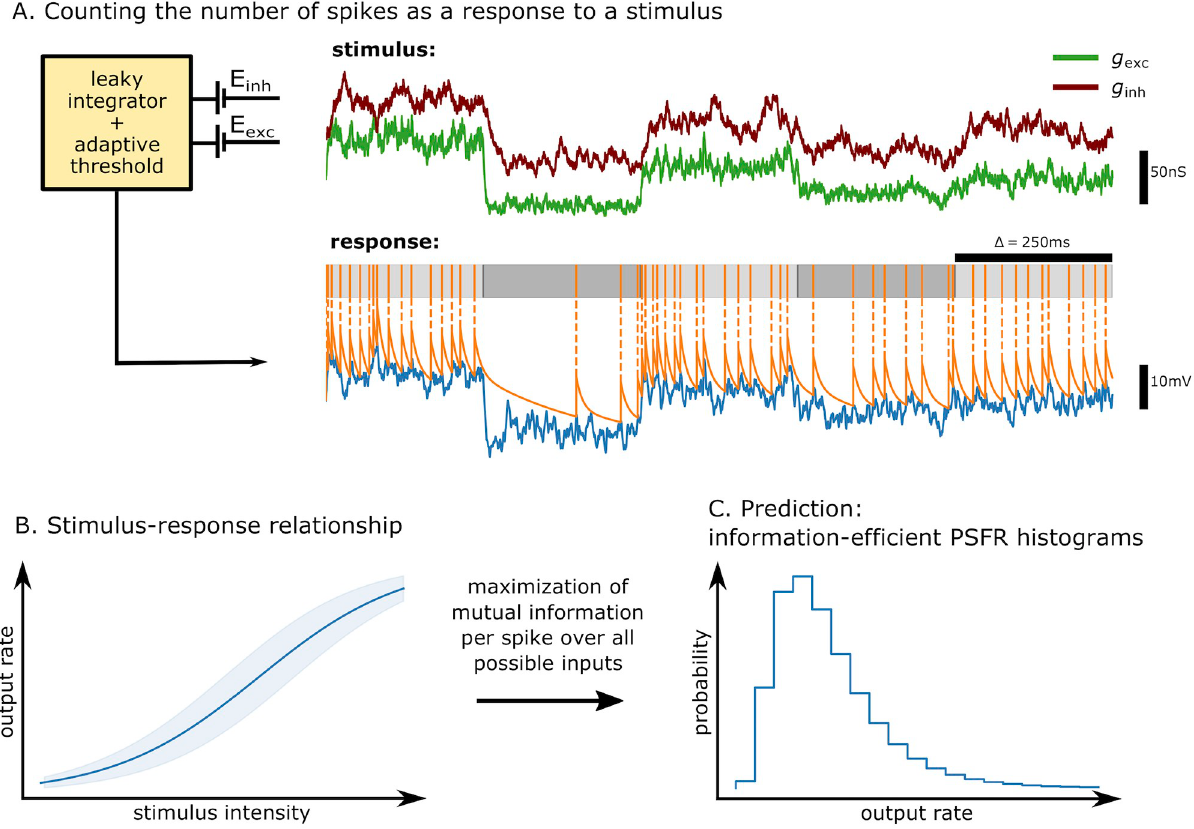
Fig 1. Graphical abstract. (A) Stimulus consisting of excitatory and inhibitory synaptic conductances, generated as shot noise with an exponential envelope, is delivered to the neuronal model, a passive leaky membrane with a dynamic threshold. The measured response is the number of spikes in a specified time window (e.g., 250 ms). (B) For each stimulus intensity the full response distribution is obtained. The mean response (solid) and its standard deviation (shaded) are shown for illustration. (C) We find the probability distribution of inputs that maximizes the mutual information between the stimulus and the response per single spike. The predicted histogram of post-synaptic firing rates (PSFR) can be compared with experimental data.